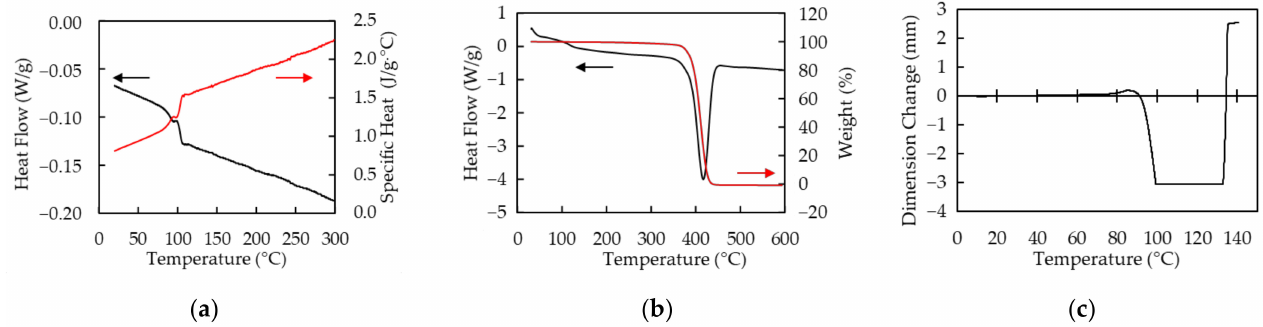
Figure 2. The thermal characteristics of polystyrene (PS) are shown. All measurements are performed under nitrogen atmosphere. ( a ) Heat flow (black line) and specific heat (red line) measured by DSC; ( b ) Heat flow (black line) and weight (red line) measured by SDT under nitrogen atmosphere; ( c ) Dimensional change measured by TMA. Static pull force of 0.1 N is applied to a sample.